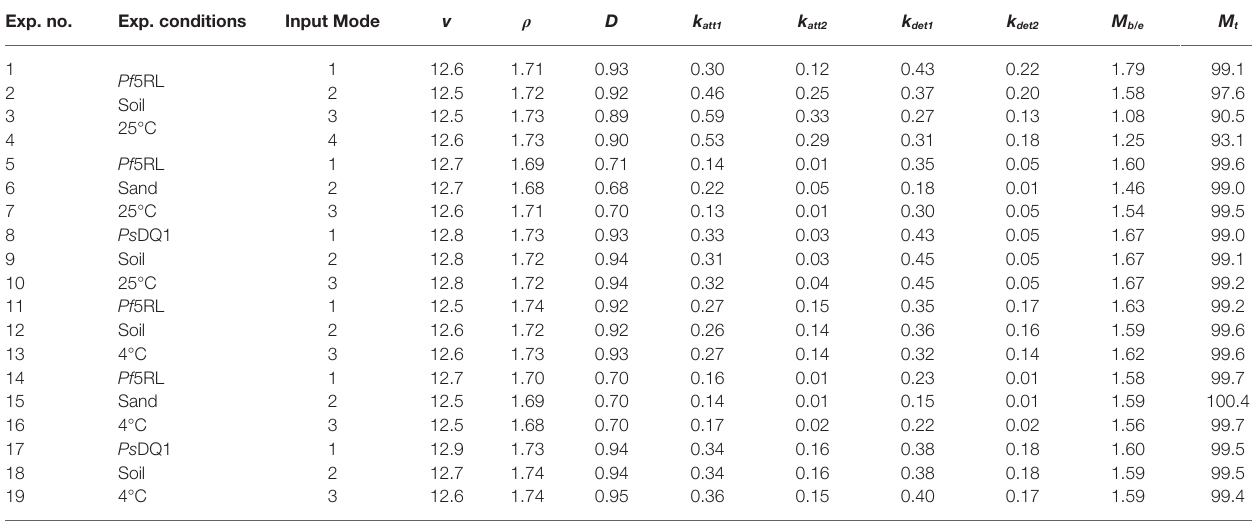
TABLE 2 | Fitted transport parameters and recovery percentages of bacteria. Exp. no.